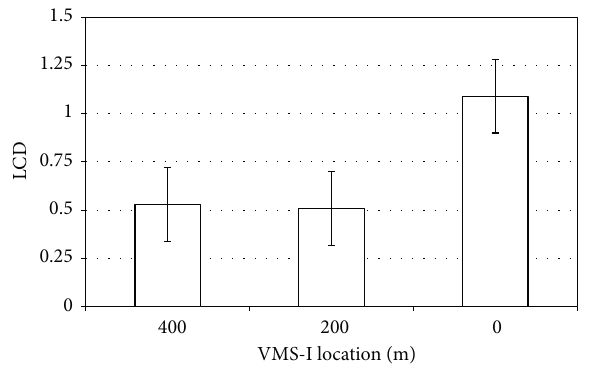
Figure 6: The influence of the VMS location on